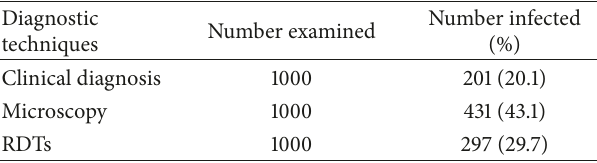
Table 1: Malaria prevalence in relation to diagnostic